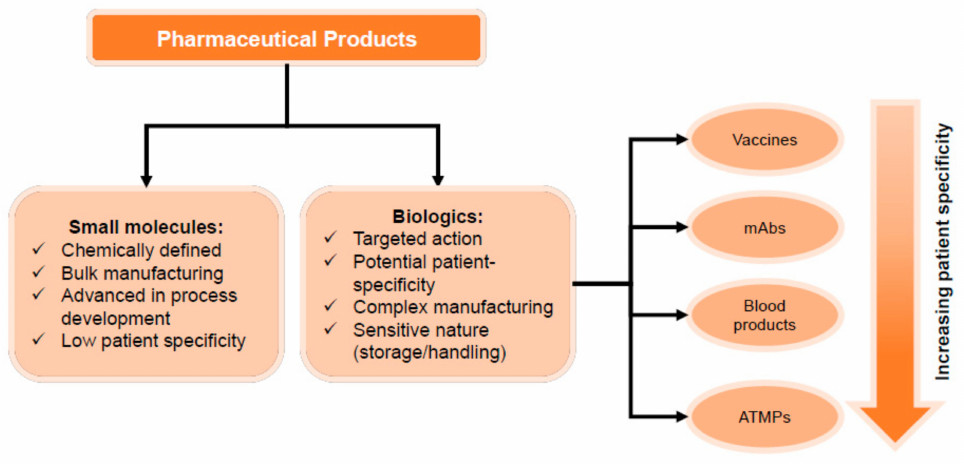
Figure 1. Schematic of simplified pharmaceutical product